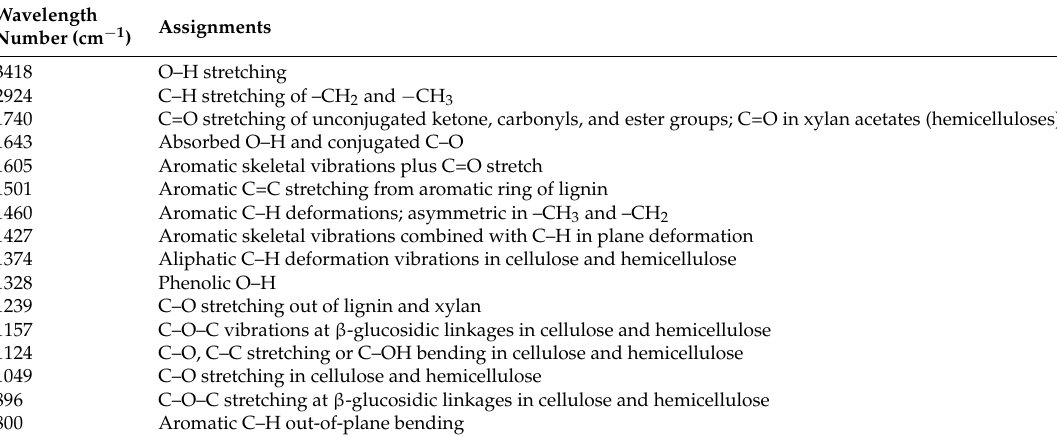
Table 3. Assignments of Absorption Bands in FTIR Spectrum of the Hydrochar Samples